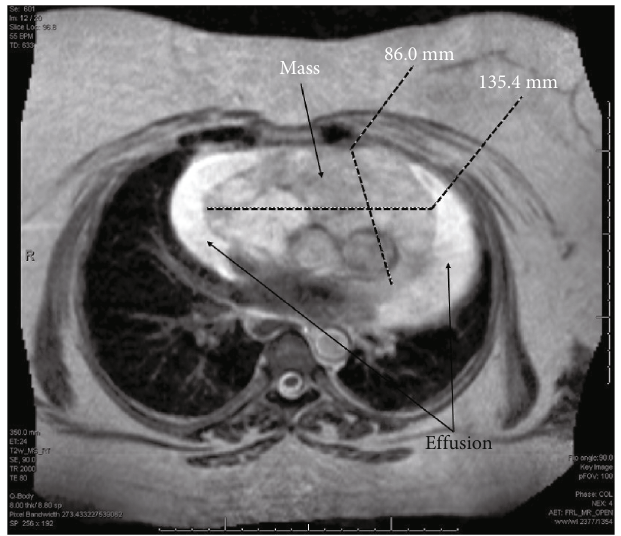
Figure 1: Magnetic resonance imaging at our institution revealed a lesion measuring 8 : 6 × 13 : 5